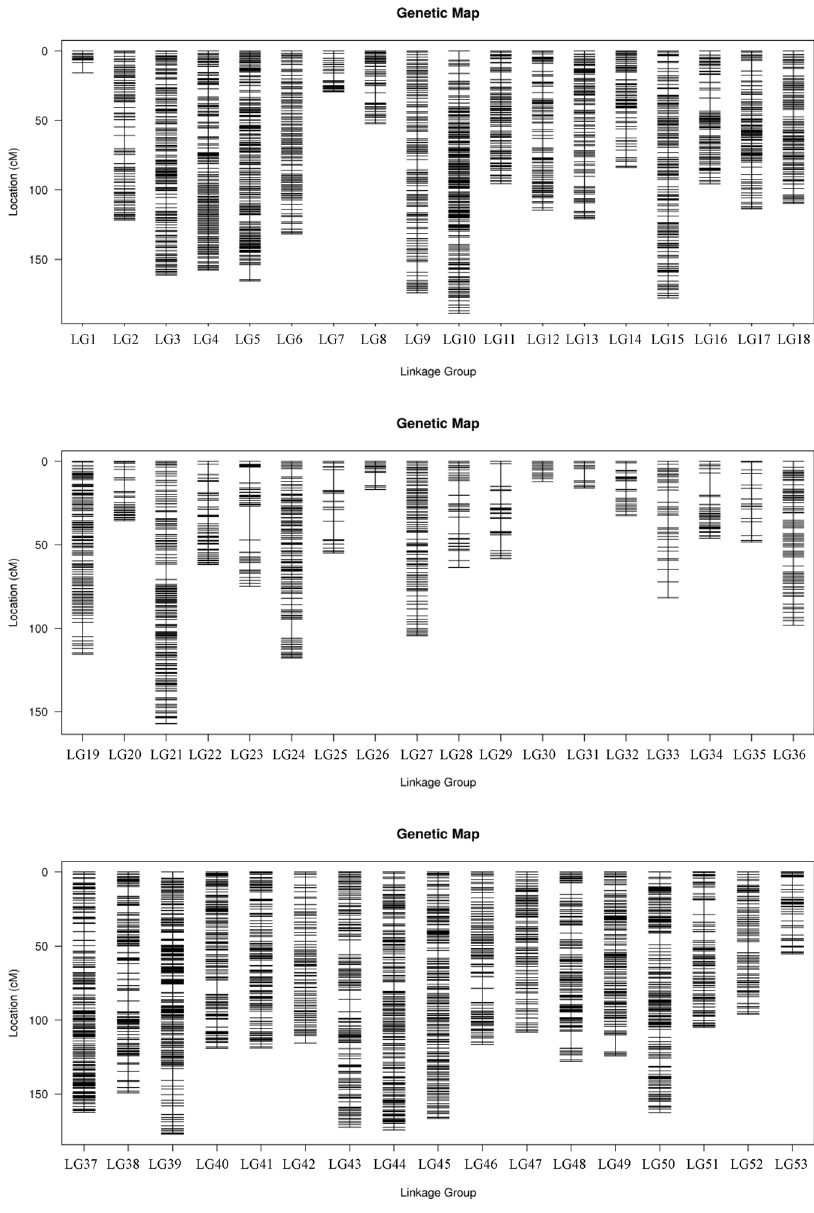
Figure 3. The sex-averaged map of P . trituberculatus